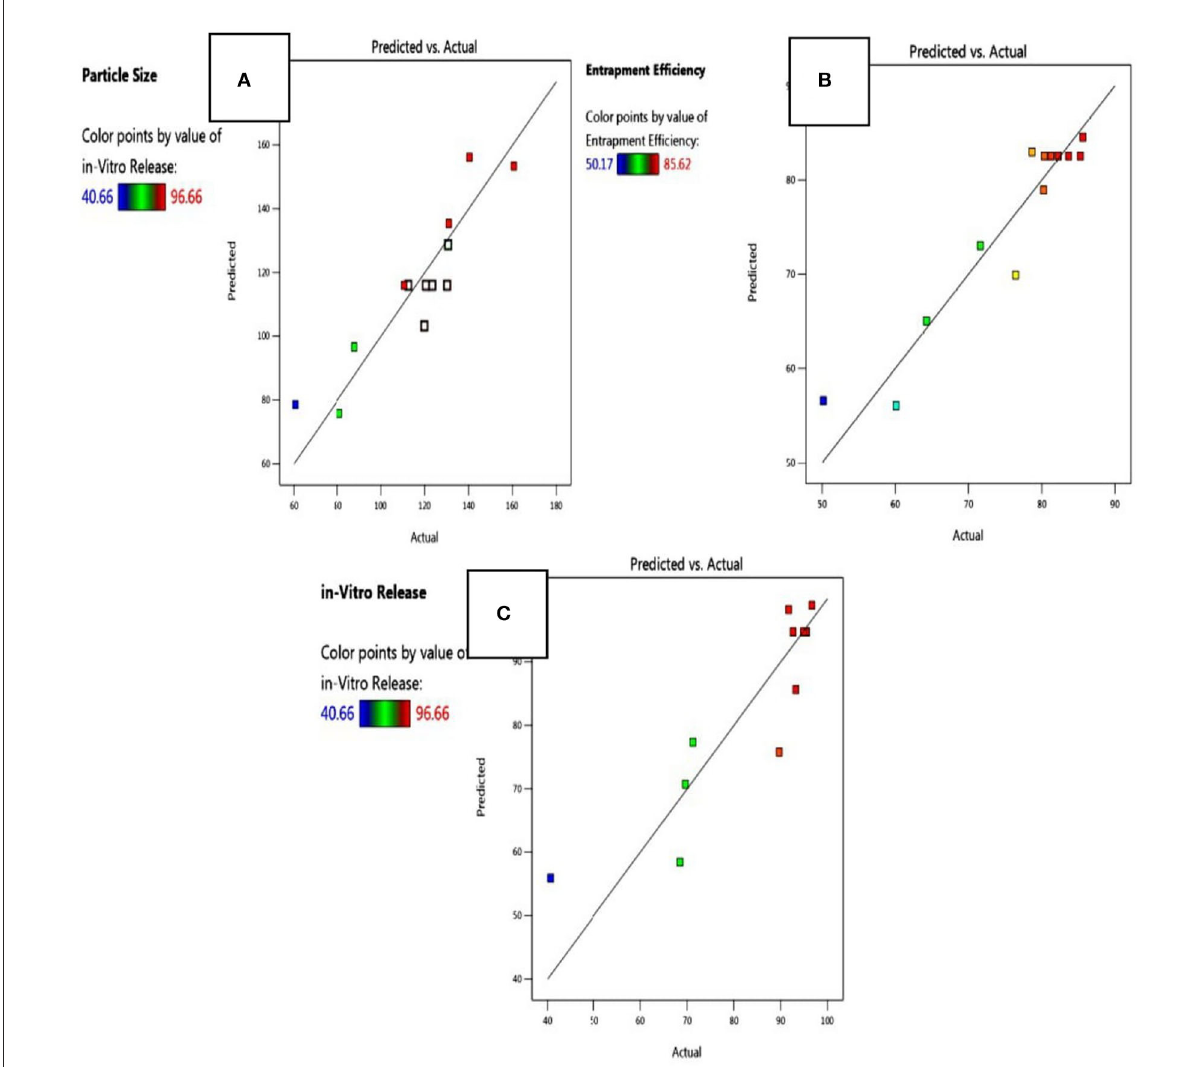
FIGURE1 Actual vs. predicted values for (A) particle size, (B) % entrapment efficiency, and (C) in vitro drug release.